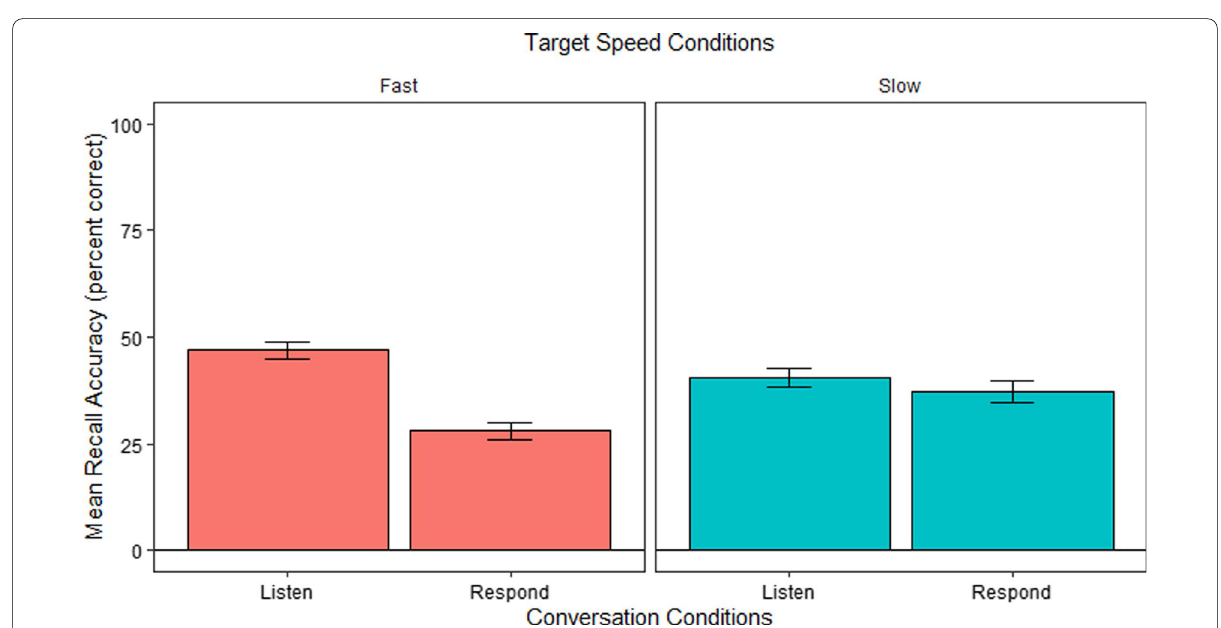
Fig. 5 Mean recall accuracy per Conversation and Speed conditions in E1. Error bars show the